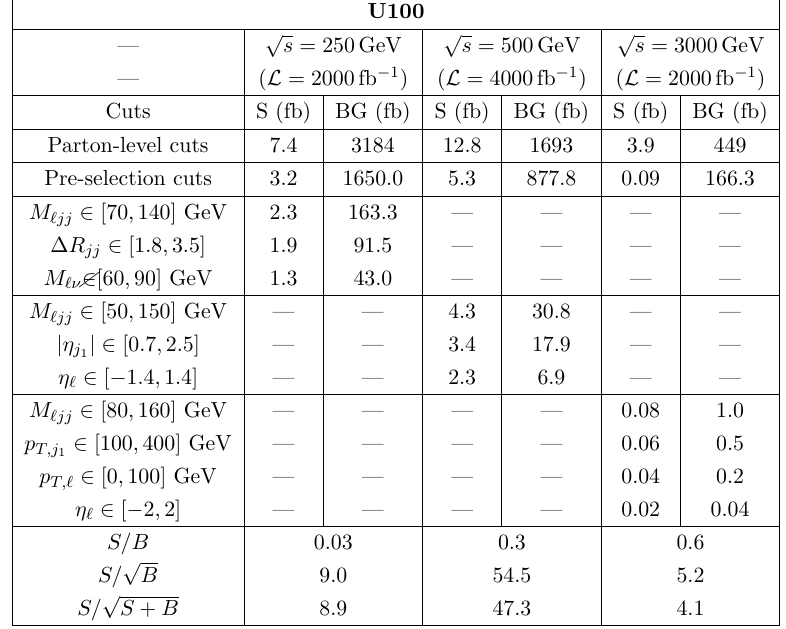
Table 9 . Cut (cid:13)ow table for uniform CW model for U100